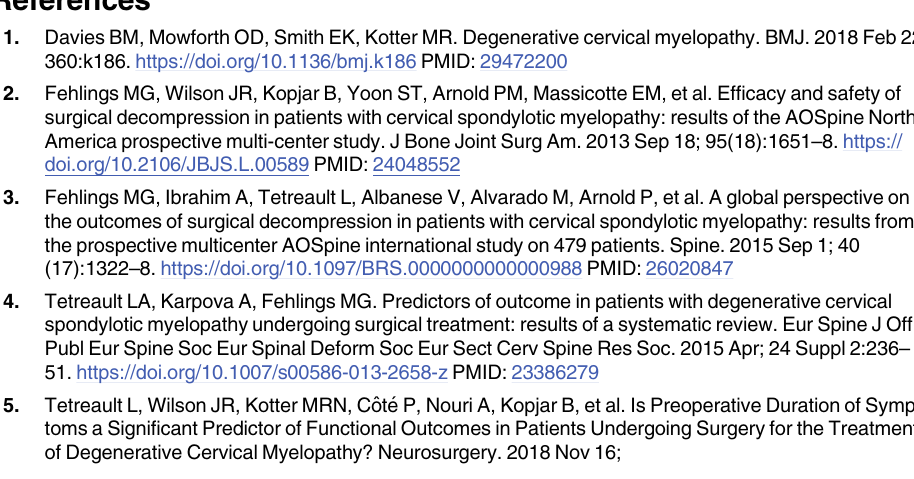
S1 Table. Short and longlisted survey outcomes. * Outcomes added after respondent sugges- tion in round 2. 2 shortlisted symptoms (italicised) were expanded “anatomically” for the long- list. S2 Table. Comparison of demographics between survey cohort and AO Spine observa- tional study. Aside from gender and time to diagnosis, the cohorts are closely matched. (DOCX) S1 Fig. Symptom frequency comparison with Tetreault et al. 2018. Comparison of matched symptoms between this study (white) and the AO Spine prospective observational study of suf- ferers undergoing surgical treatment for DCM (grey). Error bars represent 95% confidence